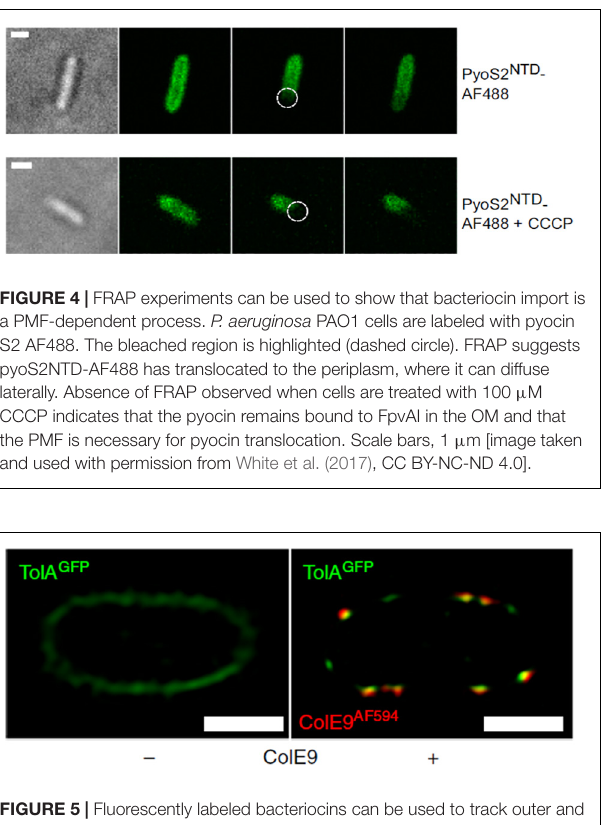
FIGURE 5 | Fluorescently labeled bacteriocins can be used to track outer and inner membrane protein clusters; used by Rassam et al. (2018) to show that bacteriocin-induced clustering of TolA in the IM mirrors that of OMPs in the OM. 2D-SIM z-slice showing significant co-clustering (yellow fluorescence) of GFP-TolA and ColE9AF594 in the IM and OM, respectively. Scale bars, 1 µ m [image taken and used with permission from Rassam et al. (2018), CC BY-NC-ND